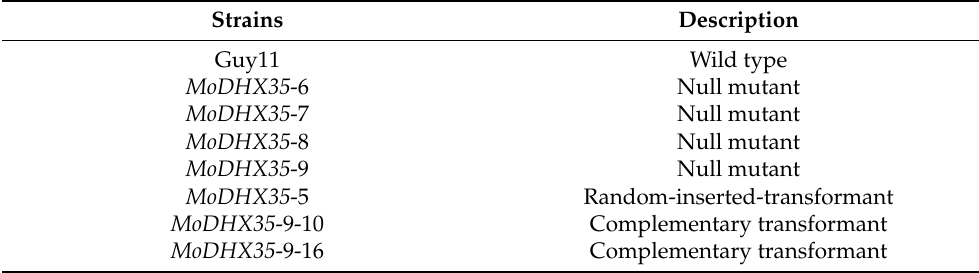
Table 1. The strains used in this study.